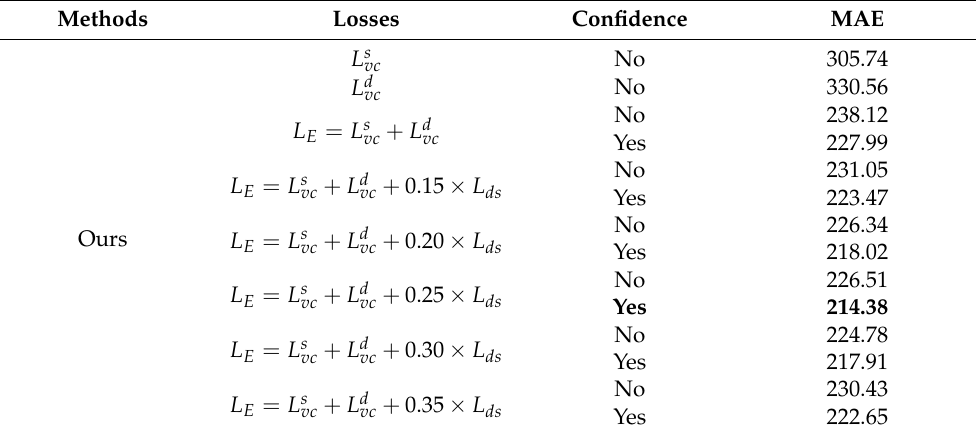
Table 6. The impact of the proposed losses in the KITTI depth completion